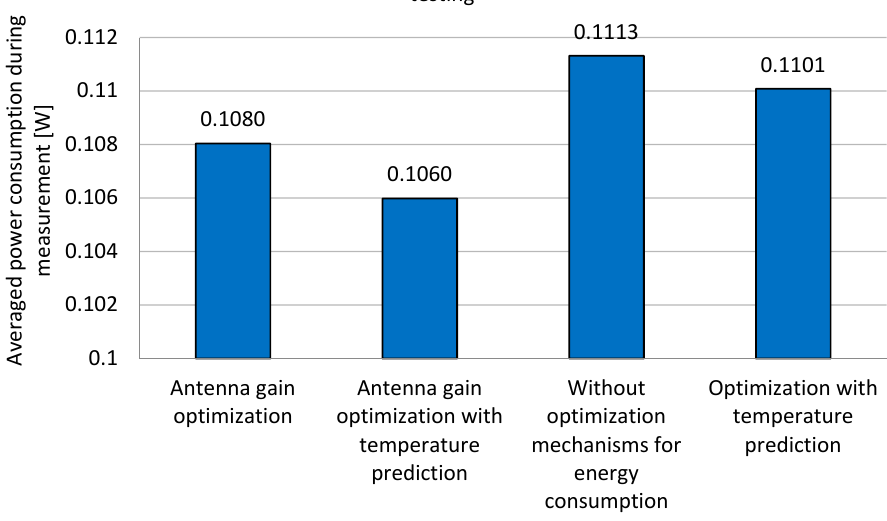
Figure 12. Comparison of the average power consumption of the terminal device for each measure- ment.